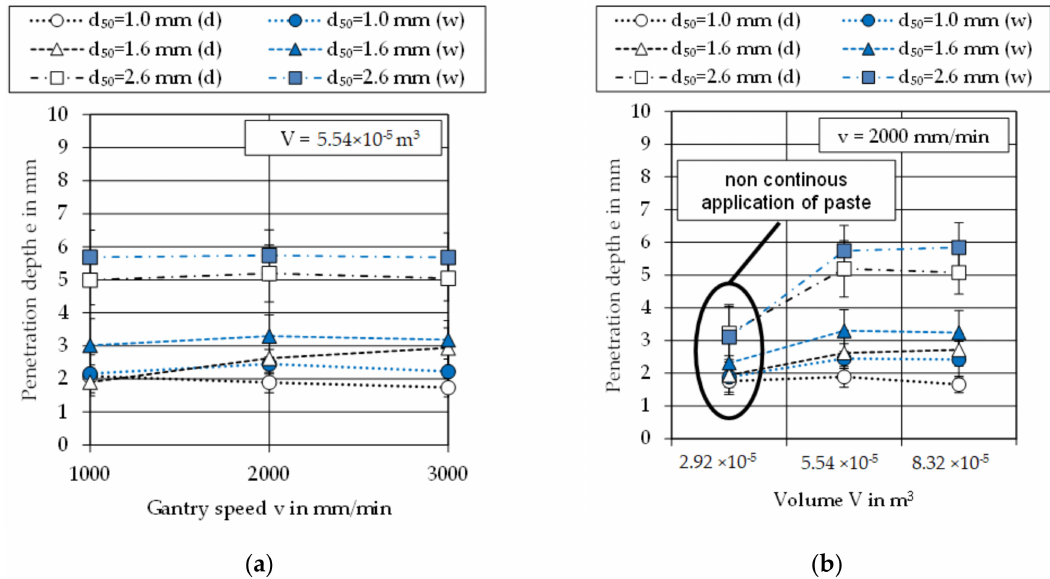
Figure A1. ( a ) Penetration depth e depending on the gantry speed; ( b ) Penetration depth e depending on the applied cement paste volume per